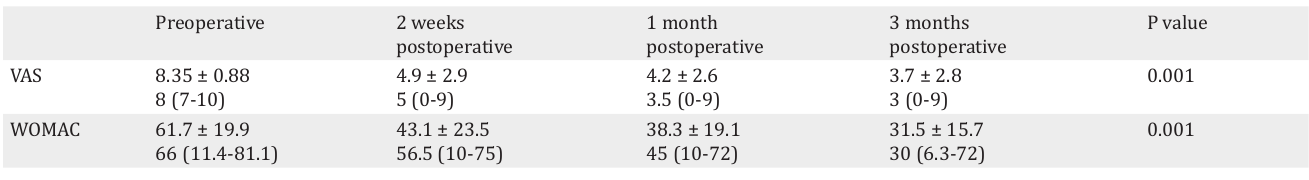
Mean age of patients in malignant and benign groups are shown.